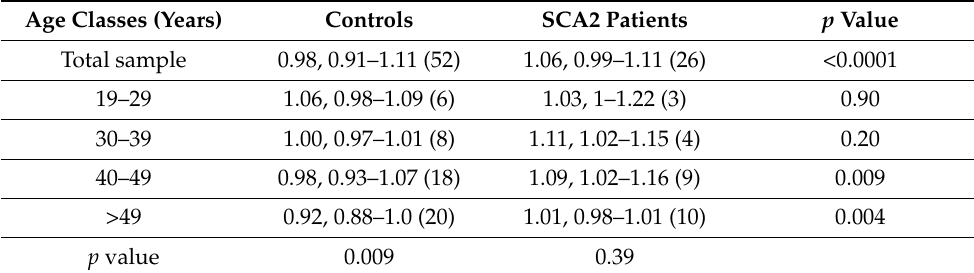
Table 2. LTL (T/S) distribution by age at blood-sampling classes (median, Q1, and Q3 (n)). There is a significant difference between controls and SCA2 patients when age is ≥ 40